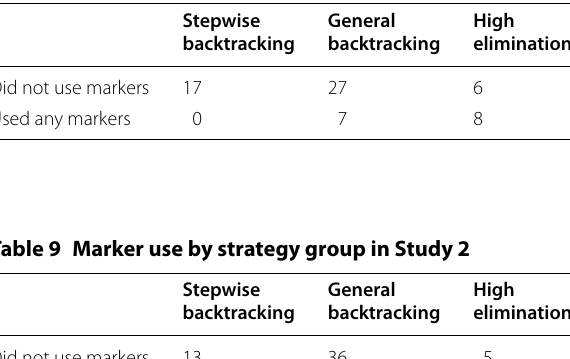
Table 8 Marker use by strategy group in study 1